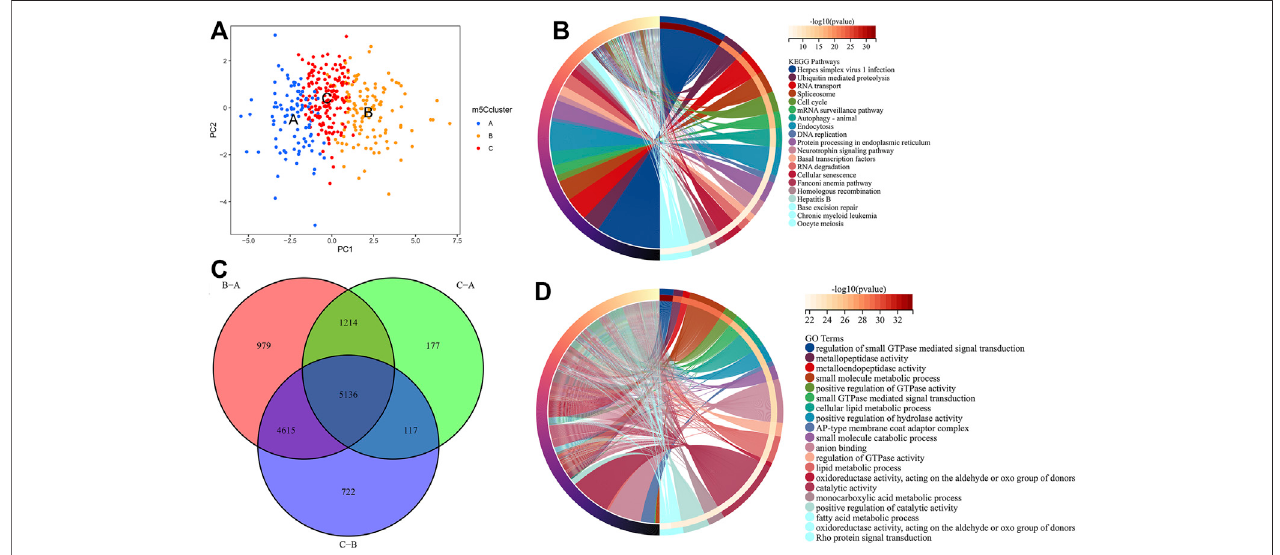
FIGURE 5 | Molecular characteristics of differentially expressed genes (DEGs) among m5Cclusters. (A) PCA among distinct m5Cclusters; (B) DEGs extracted among three m5Cclusters; (C) KEGG pathway analysis for the DEGs; (D) GO enrichment analysis for the DEGs.